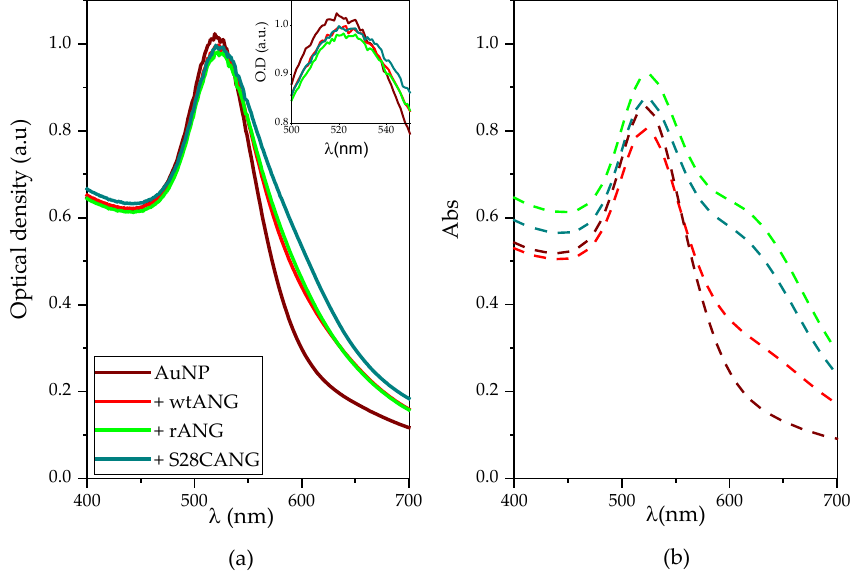
Figure 1. Ribonucleolytic activity of wtANG and S28CANG. Assay was performed at increasing protein concentration (0.2, 0.5, 1, 1.5 μg/mL), in 33 mM MOPS buffer, at 37 °C for 2 h, with the addition of 6 × 10 2 μg/mL tRNA. Averaged values and standard deviation from three experiments.